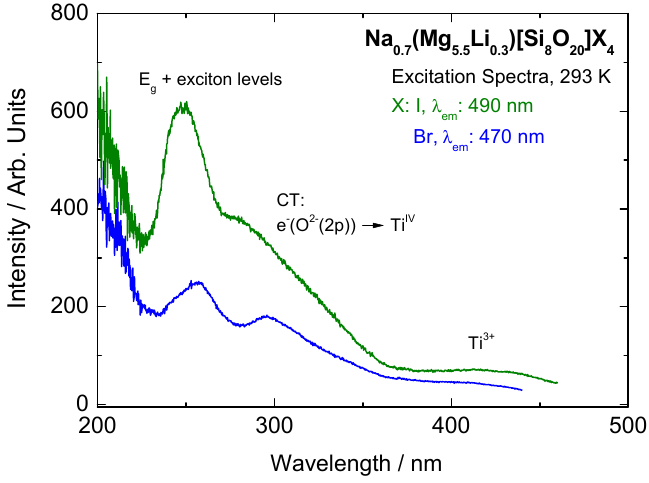
Figure 8. The excitation spectra of the bromohectorite ( λ em : 470 nm) and iodohectorite ( λ em : 490 nm).